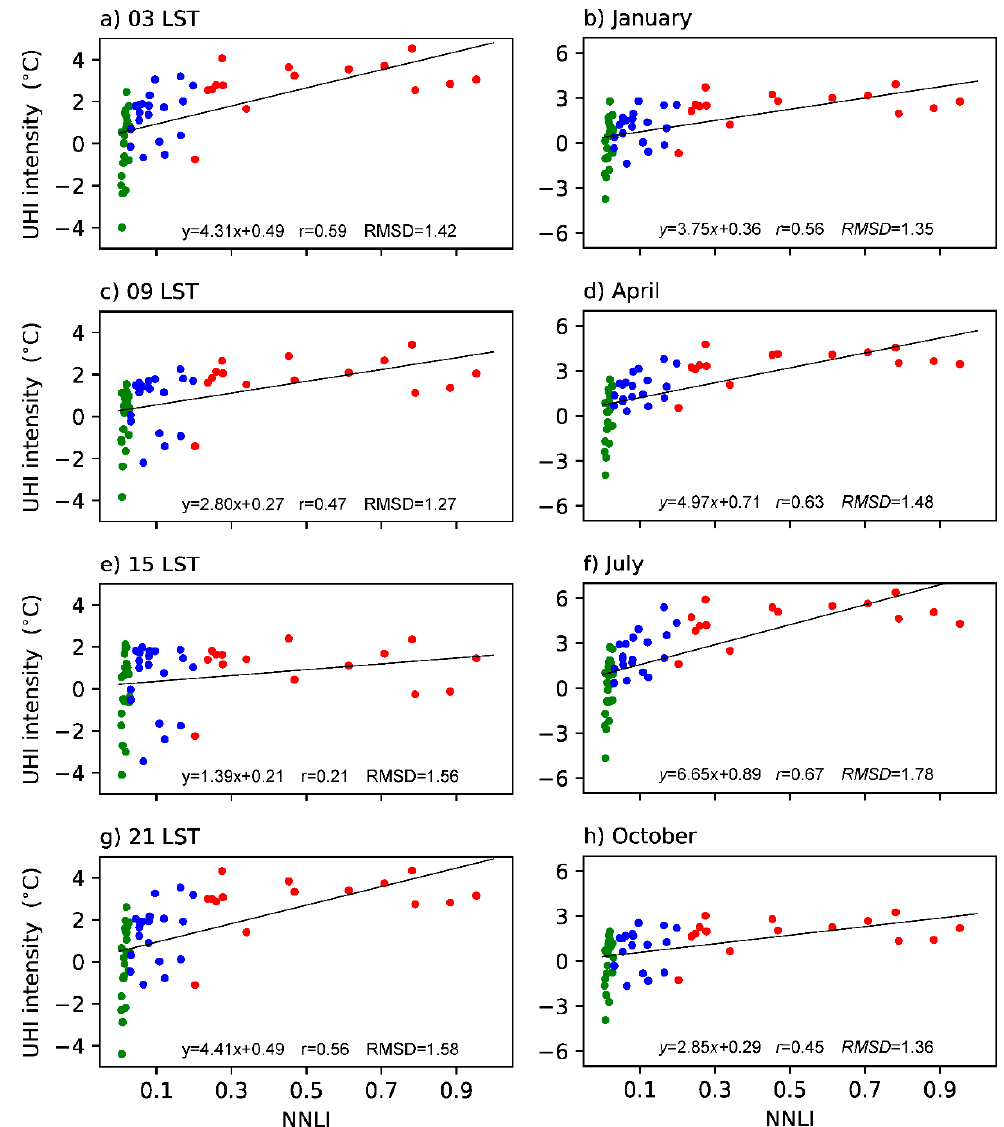
Figure 5. Correlations between UHI intensity (°C) and NNLI. ( a ), ( c ), ( e ) and ( g ) denote diurnal cycle, and are for 03, 09, 15 and 21 LST, respectively. ( b ), ( d ), ( f ) and ( h ) denote seasonal cycle, and are for January, April, July and October, respectively. Red, blue, and green dots indicate urban, suburban and rural sites, respectively.